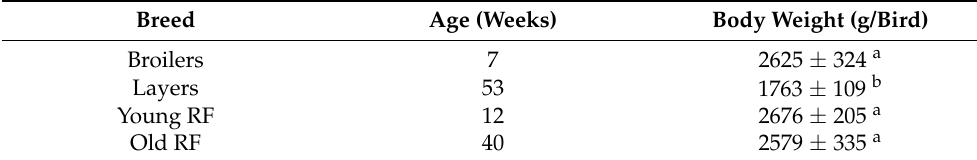
Table 1. Age and body weight of chickens. Breed Age (Weeks) Body Weight (g/Bird) Broilers 7 2625 ± 324 a Layers